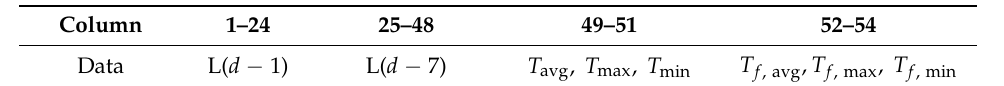
Table 1. Input data